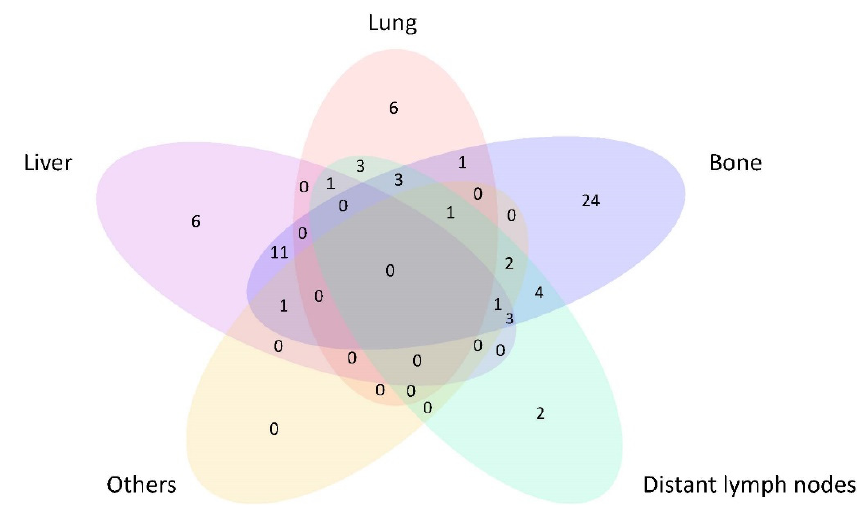
Figure 2. Venn diagram showing the distribution of various sites of distant metastases at presentation in the training cohort.